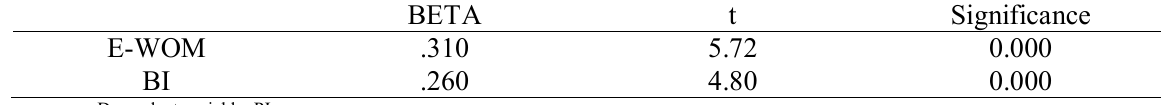
The results of regression